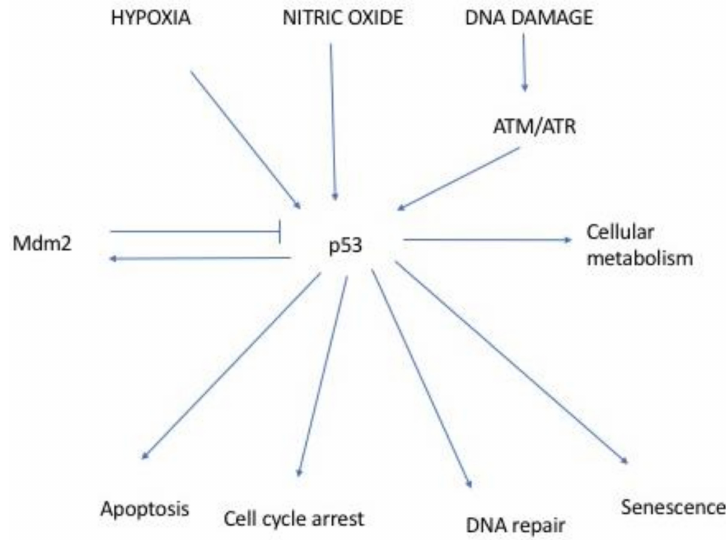
Figure 1. Basic functions of p53. p53 levels are tightly controlled and in unperturbed cells MDM2 is its main regulator via induction of p53 degradation. There is a negative feedback loop between the two proteins. p53 itself induces MDM2 transcription, hence as p53 levels increase, more MDM2 is produced, which in turn down regulates p53 levels. In the presence of DNA damage and other stresses, p53 degradation stops and its levels increase. Elevated levels of stabilized p53 induce transcription of proteins involved in different types of responses, particularly cell cycle arrest and apoptosis. Modified schematic diagram